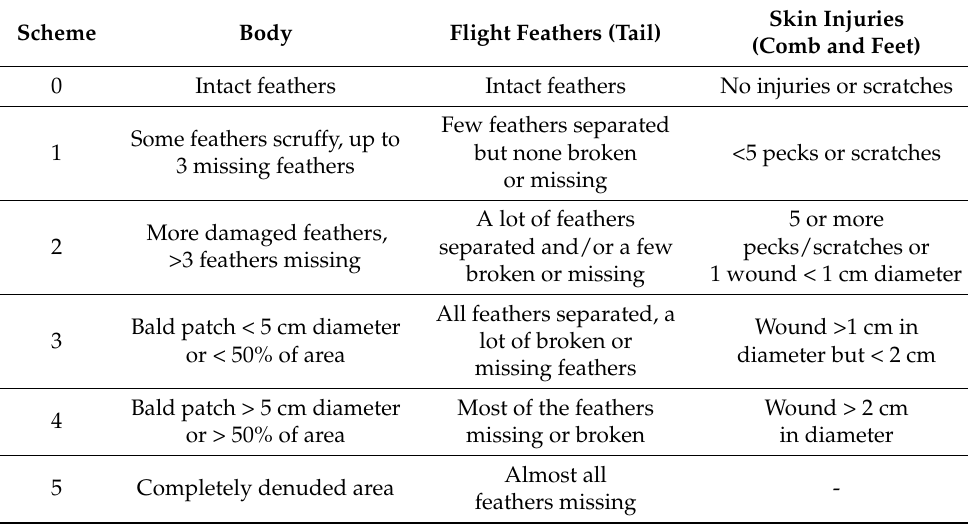
Table 2. Protocol used for integument and plumage